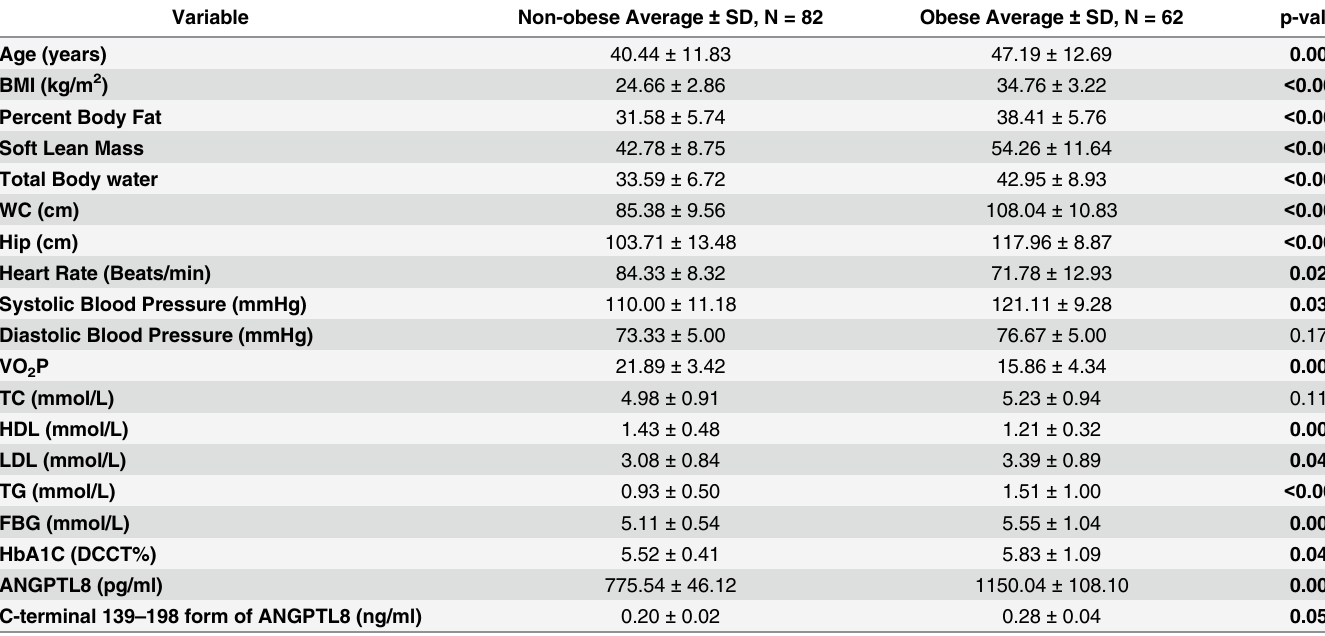
Table 1. Characteristics of the non-obese and obese subjects included in this